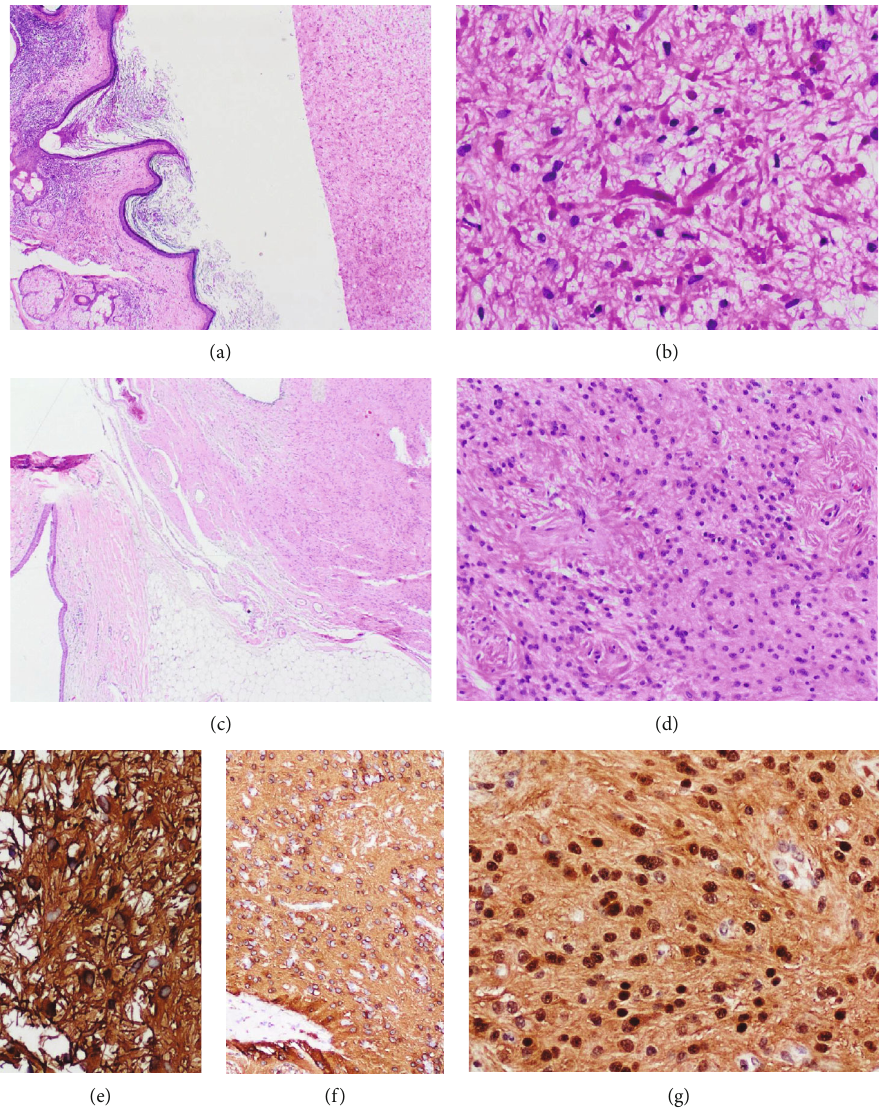
Figure 1: Hematoxylin and eosin (H&E) stains and immunohistochemistry. (a) Low-power fi eld examination shows cystic spaces lined by mature squamous cell epithelium with underling pilosebaceous units and adjacent pilocytic astrocytoma (H&E, 4x). (b) Bipolar cellular neoplasm of low-grade cytology along with tapered corkscrew-shaped brightly eosinophilic hyaline material (Rosenthal fi bers) (H&E, 40x). (c) A low-power fi eld demonstrates a separate focus of subependymoma comprised of bland monomorphic cellular proliferation in a dense, fi ne, glial fi brillary background (H&E, 2x). (d) Clusters of isomorphic nuclei with occasional pseudorosettes (H&E, 40x). (e, f) GFAP revealed strong di ff use staining in the pilocytic astrocytoma and in the subependymoma (f), respectively (40x). (g): S100 revealed strong di ff use staining in the subependymoma